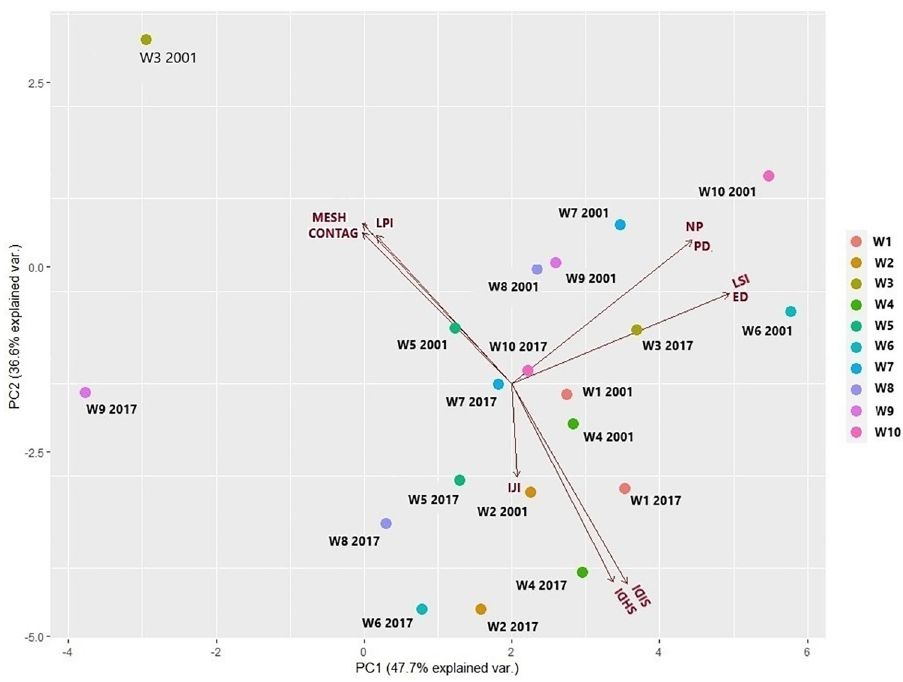
Fig 7. Ordination plot of landscape-level metrics (colors: